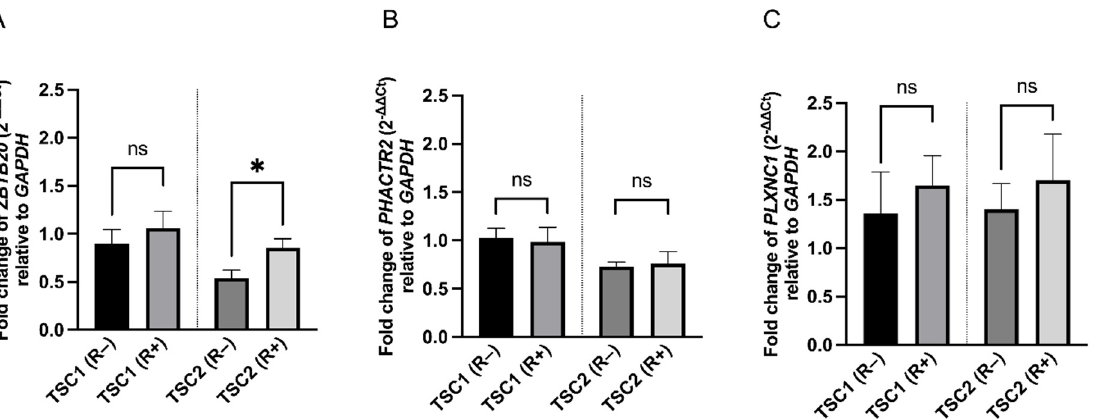
Figure 5. Effect of rapamycin treatment on ZBTB20 ( A ), PHACTR2 ( B ) and PLXNC1 ( C ) genes in TSC1 or TSC2 defected cells. Asterisks represent statistical significance from an unpaired Student’s t -test (* p < 0.05), ns represents no statistical significance. Error bars represent SEM values.